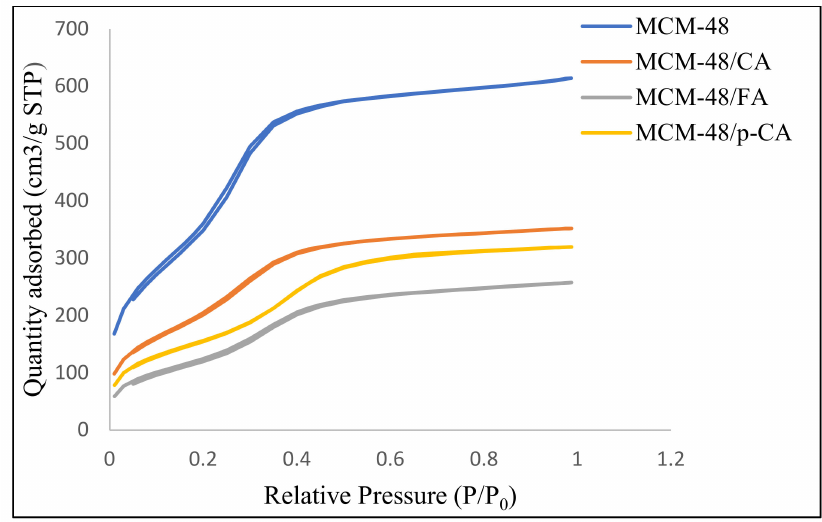
Figure 5. Adsorption isotherms recorded on materials MCM418, MCM-48/CA, MCM-48/p-CA and MCM-48/FA.